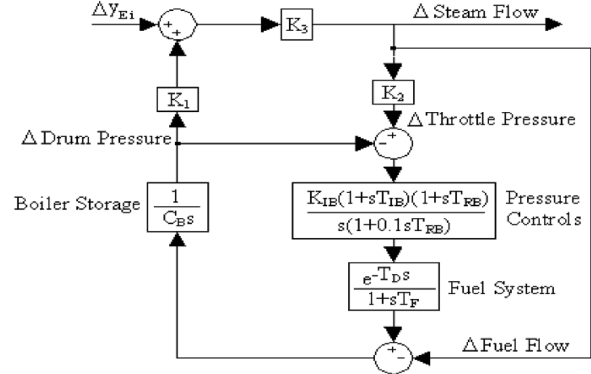
Fig. 2 Boiler dynamics model